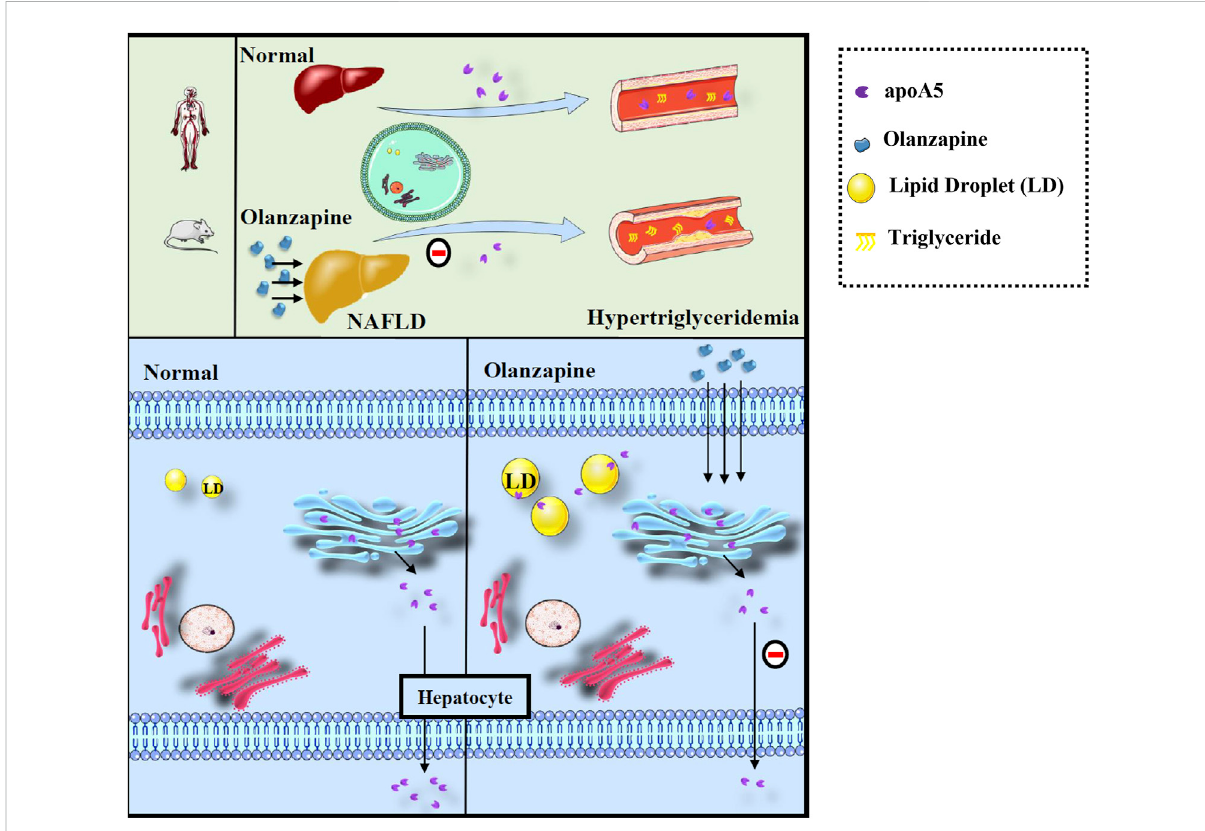
FIGURE 5 Defects of sorting and secretion of hepatic apoA5 by olanzapine leads to hypertriglyceridemia and lipid droplets accumulation in the liver. ApoA5 is synthesized in the endoplasmic reticulum of hepatocytes and then transported to the Golgi body, which releases it, as needed. Olanzapine intervention does not affect the processes of apoA5 transcription and translation but disturbs hepatic sorting and secretion of apoA5 into the blood, and the reduction of circulating apoA5 results in hypertriglyceridemia. Moreover, apoA5 accumulation in the liver promotes the formation of lipid droplets (LD), inhibits lipid-droplet hydrolysis, and promotes triglyceride accumulation in hepatocytes, potentially increasing the risk of